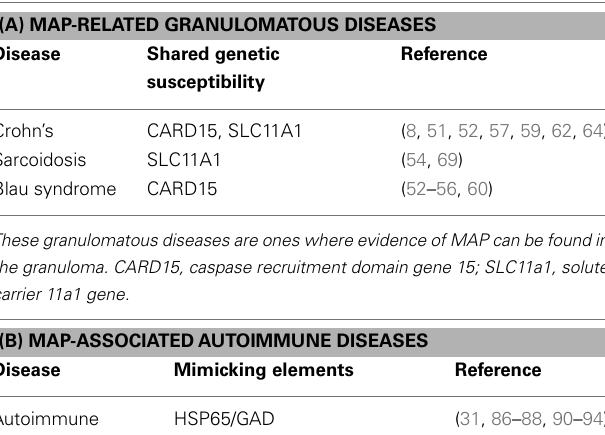
Table 1 | (A) Map-related granulomatous diseases. (B) Map-associated autoimmune diseases